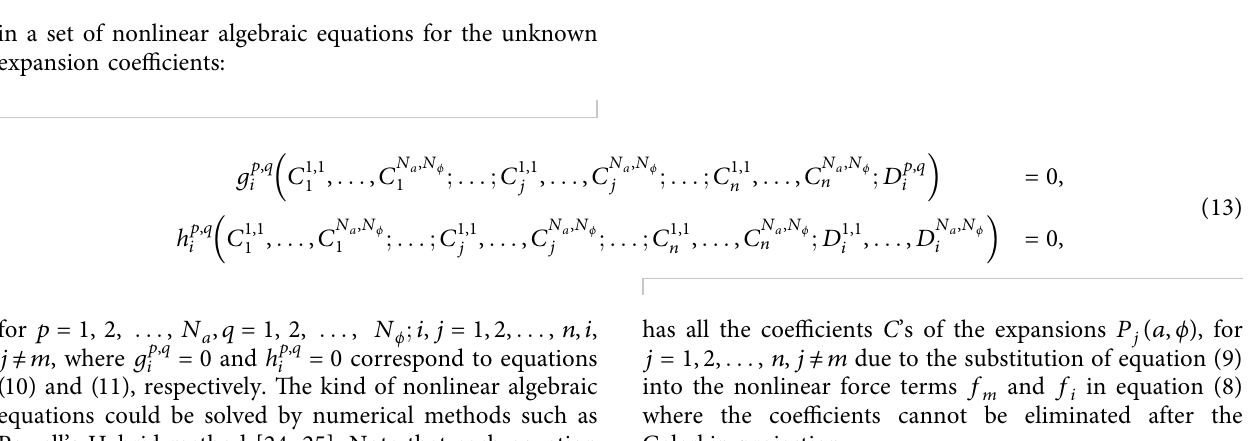
( η , _ η ) of NNM 1 1 Sub , 1 ( η , _ η ) � P ( a, ϕ ) � ( 􏽐 N a C k, 1 L ( a )) · cos ϕ ; (b) piecewise linear function of finite-element approximation L ( a ) ; k Sub , 1 k � 1 1 1 Sub , 1 ( η , _ η ) � P ( a, ϕ ) � ( 􏽐 N a C k,l L ( a )) · cos (( 2 l − 1 ) ϕ ) , for l � 2 , ... , 5; (d) the k Sub ,l k � 1 1 1 Sub ,l ( η , _ η ) 2 1 1